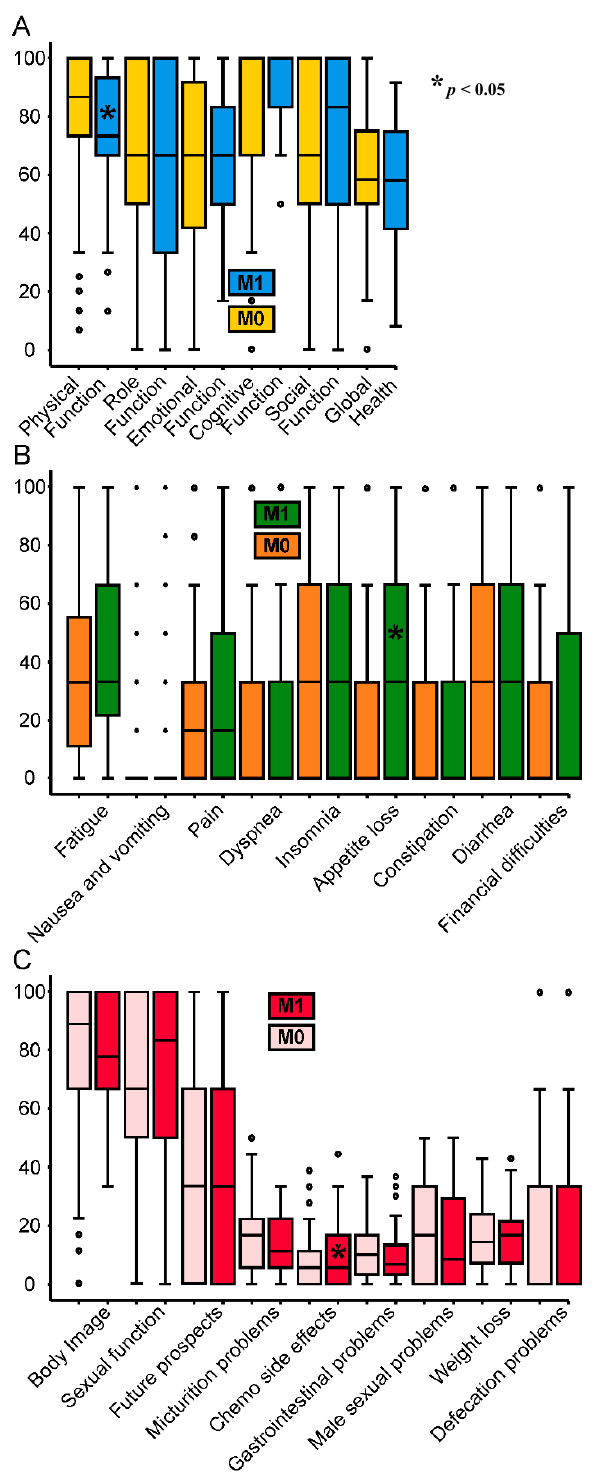
Figure 2. Side-by-side box plots M0 ( n = 183) vs. M1 ( n = 50) of baseline ( A ) QLQ C30 functional scores M0 (yellow), M1 (blue), ( B ) QLQ C30 symptom scores M0 (orange), M1 (green), ( C ) QLQ CR38 scores M0 (pale pink), M1 (red), * marks domains significant in an unpaired t -test.